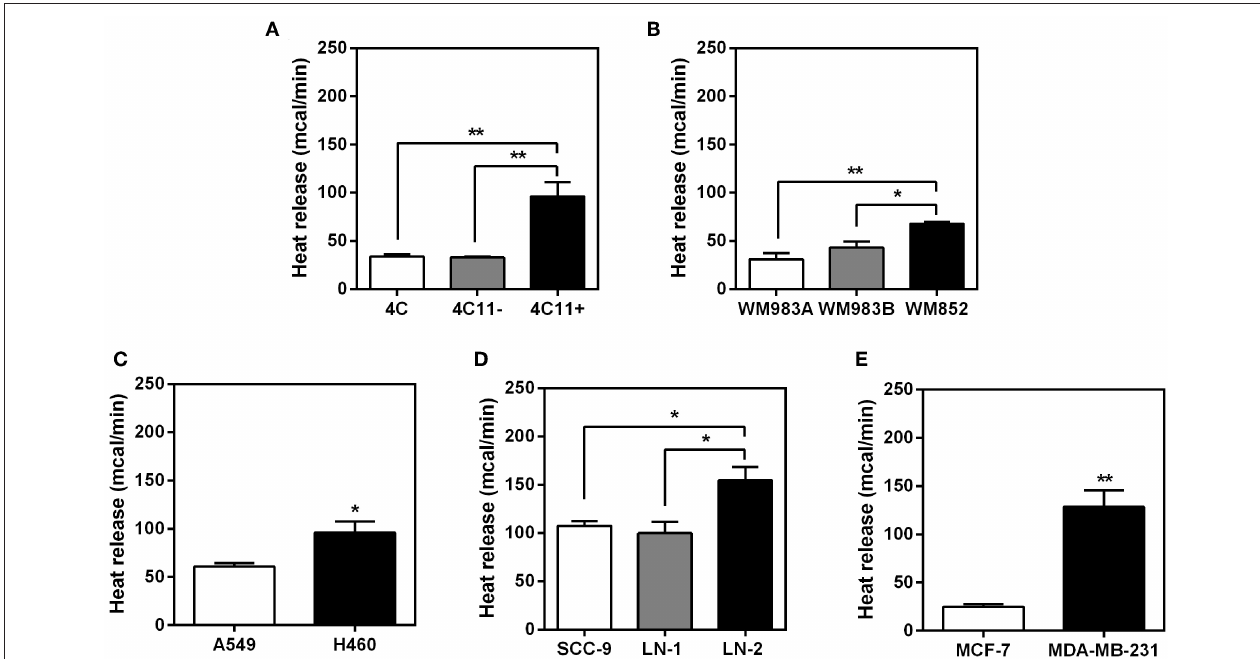
FIGURE 1 | Heat release by different types of intact tumor cells.The bars represent the release of total heat of living cells in 35min of experiment. Bars: white—non-metastatic tumor cells; gray - cells with intermediate metastatic potential; black - cells with high metastatic potential. (A) Murine melanoma cells 4C, 4C11 − and 4C11 + ; (B) human melanoma cells WM983A, WM983B and WM852; (C) human non-small-cell lung adenocarcinoma cells A549 and H460; (D) human oral squamous carcinoma cells SCC-9, LN-1 and LN-2; (E) human breast cancer cells MCF-7 and MDA-MB-231. Values were expressed as mean ± SEM. * p < 0.05; ** p <